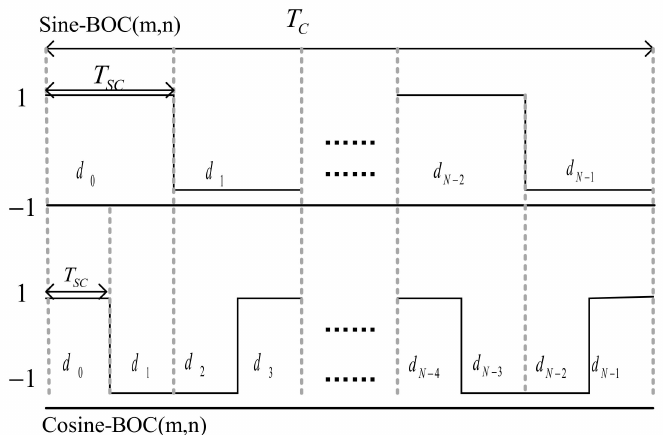
Figure 1. Binary offset carrier (BOC) signals and shape vectors. For Sine-BOC( m , n ), N = 2 m / n and the shape vector is d = [ 1 − 1 1 · · · − 1 ] ample, the shape vector of Sine-BOC(1,1) is d = [ 1 − 1 ] BOC( m , n ), N 1 = 4 m / n . The shape vector of Cosine-BOC(1,1) is d = [ 1 − 1 1 − 1 ] Tsc = Tc